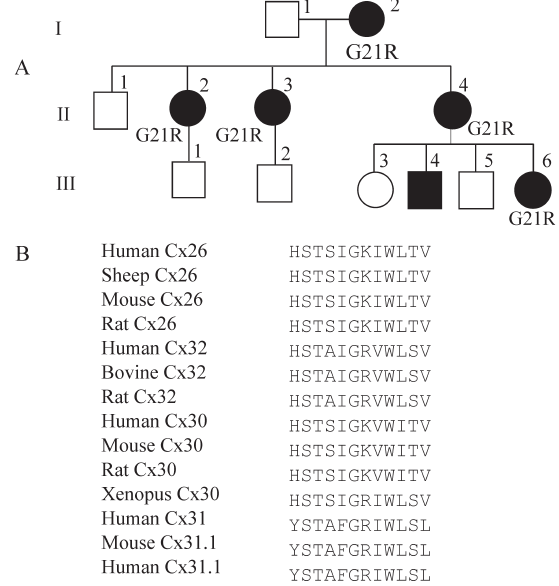
Figure 1 - A: Pedigree of the family carrying the GJB2 G21R mutation. TheDNAforindividualswithnogenotypewasnotavailable.B:Compari- son of the conservation of position 21 and surrounding amino acids in dif- ferent connexins and in different species.